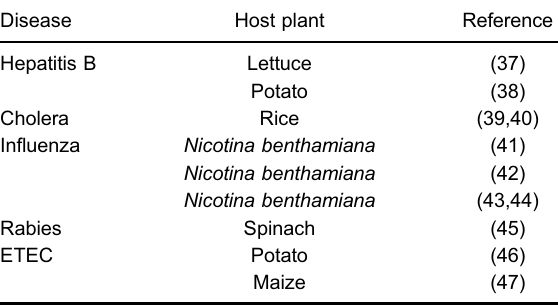
Table 2. Edible plant vaccines for various diseases in human clinical trials.